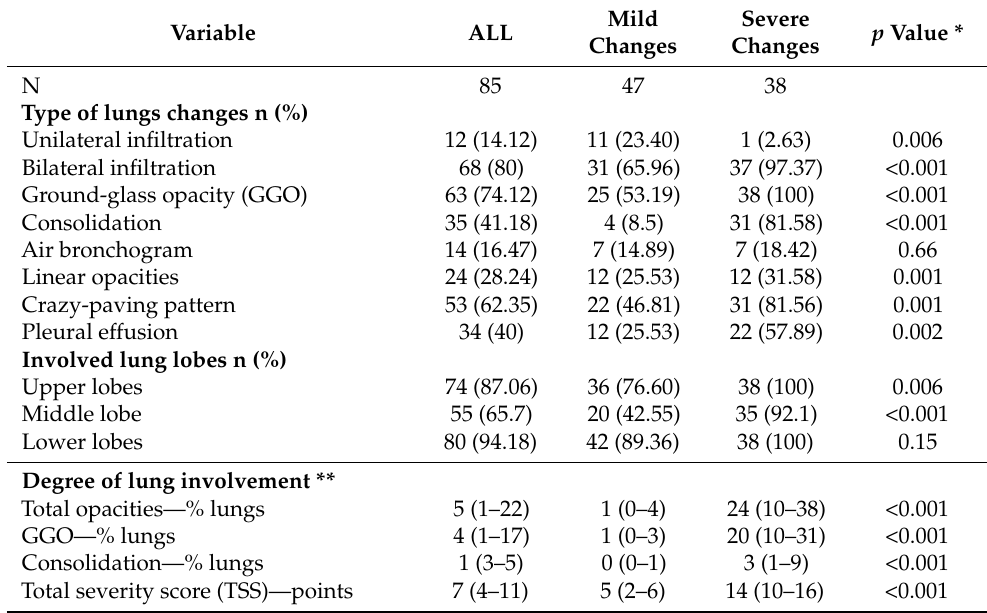
Table 3. Chest computed tomography